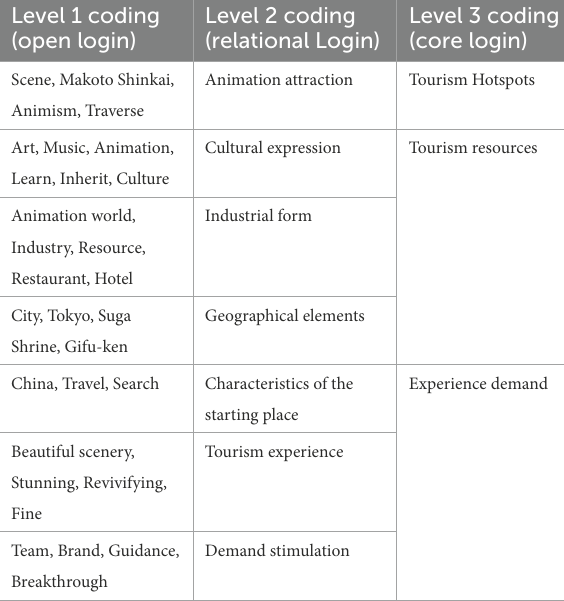
TABLE 3 Coding of interactive elements of Interest-related community based on tourism hosts. Level 1 coding (open